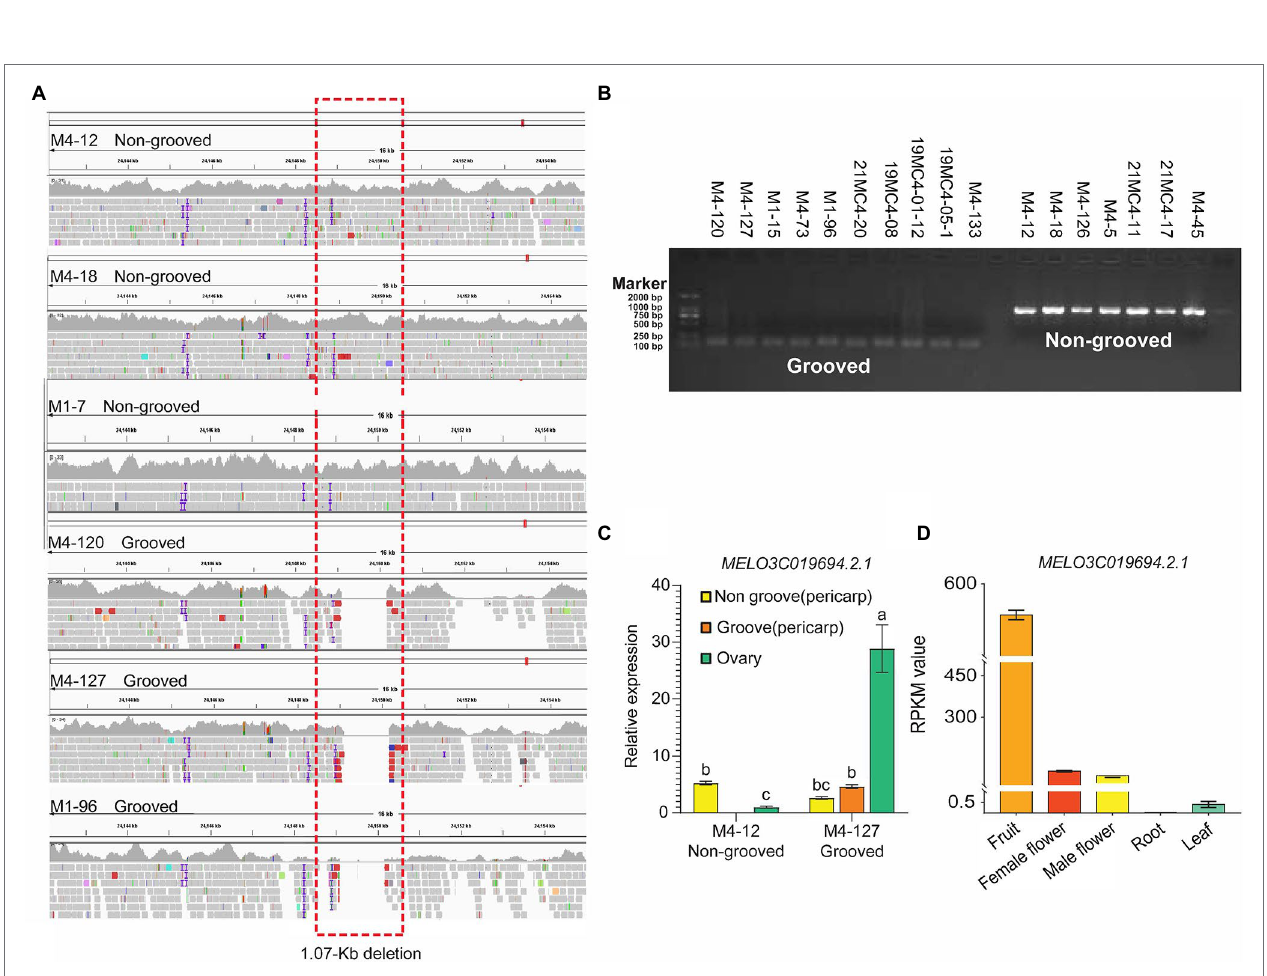
FIGURE 4 | Candidate gene analysis. (A) Sequence alignment of the 1,070-bp deletion region from different materials at 23.85 kb upstream of MELO3C019694.2.1 . (B) Bands of amplified Chr11_24149068 from 11 melon materials. (C) The expression level of the gene in the parental ovary and the grooved and non-grooved pericarp of the mature fruit. (D) Gene transcription data from fruit, female flowers, male flowers, roots, and